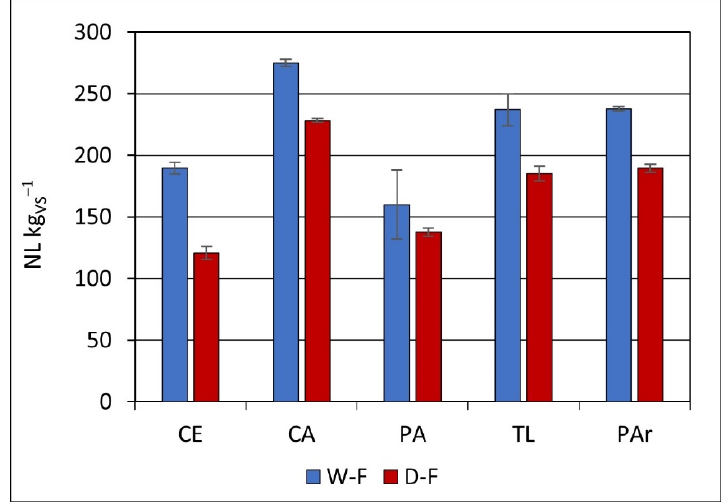
Figure 1. Specific methane yield (SMY) produced by both types of fermentation: W–F—wet fermentation; D–F—dry fermentation. CE— Carex elata ; CA— Carex acutiformis + Carex elata ;